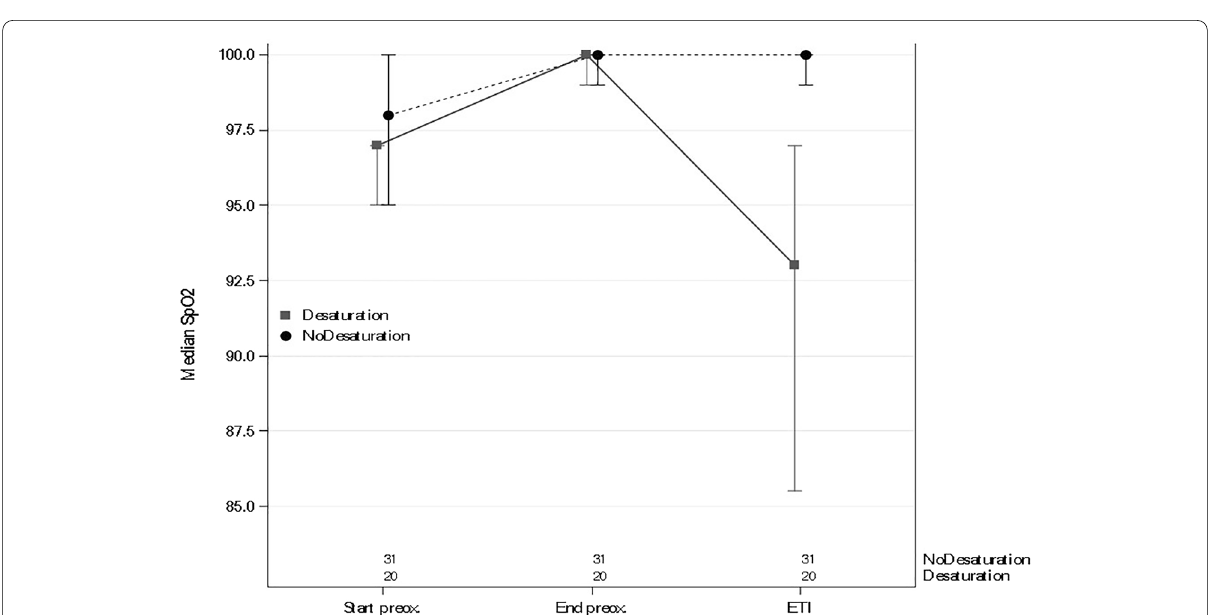
file 2: Figure S2 shows changes in SpO 2 and ORI in the subset of patients who had moderate hypoxemia and Additional file 3: Figure S3 shows changes in all patients.